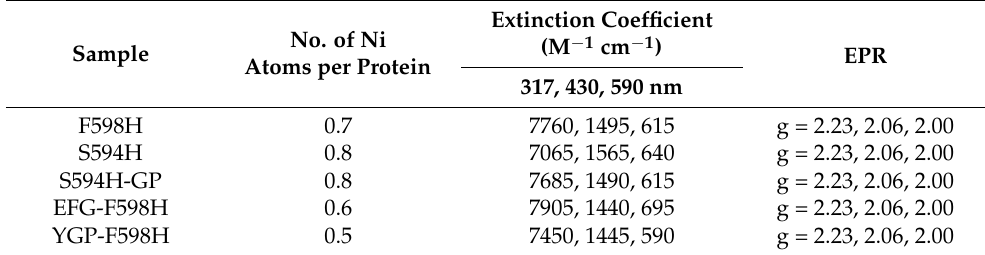
Table 1. UV-Vis and EPR data of ACS- α 15